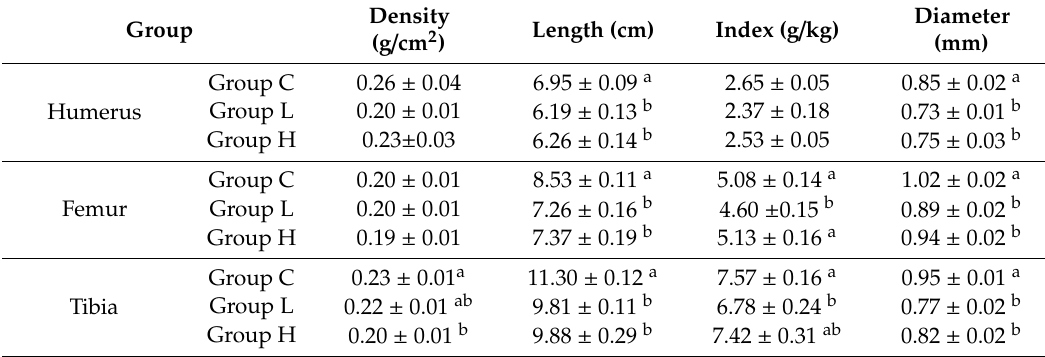
Table 6. The 42-d changes of bone parameters in